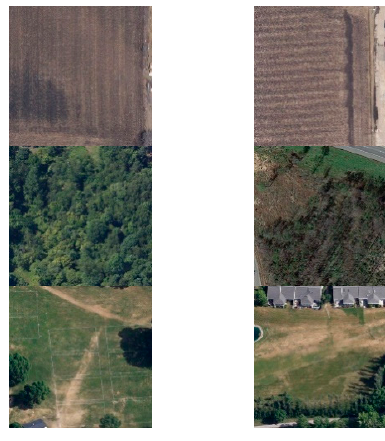
Figure 13. Randomly sampled images from UCM, SIRI-WHU, NWPU-RESIST45, and RSSCN7 da- tasets. The first, second, third and fourth rows of ( a ) correspond to the scene classes of golf course in UCM dataset, farmland in SIRI-WHU dataset, parking lot in SIRI-WHU dataset, and farmland in the NWPU-RESIST45 dataset. The first, second, third, and fourth rows of ( b ) correspond to the scene classes of parking lot, industrial region, industrial region, and residential region in the RSSCN7 da-